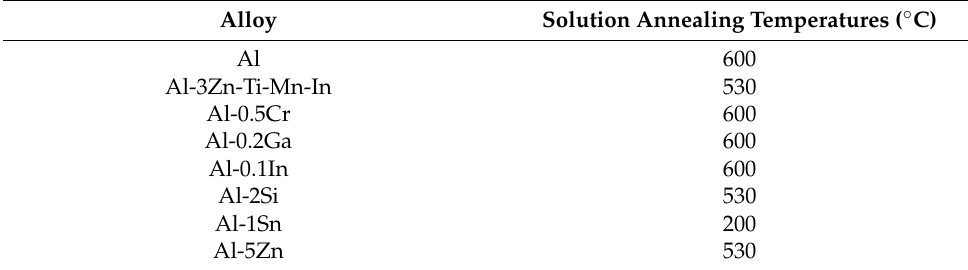
Table 1. Solution treatment temperatures of binary Al-based alloys.